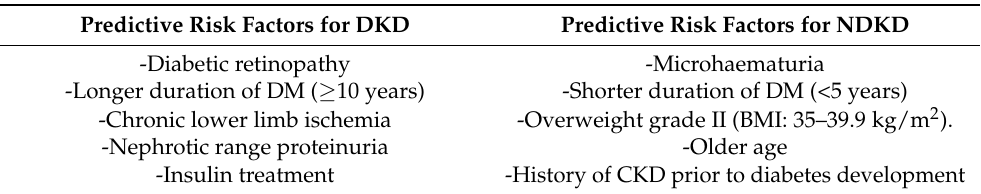
Table 1. Predictive risk factors for diabetic and non-diabetic kidney disease. Clinical findings that may help to identify diabetic and non-diabetic kidney disease in patients with diabetes and CKD. Predictive Risk Factors for DKD Predictive Risk Factors for NDKD -Diabetic retinopathy -Microhaematuria -Longer duration of DM ( ≥ 10 years) -Shorter duration of DM (<5 years) -Chronic lower limb ischemia -Overweight grade II (BMI: 35–39.9 kg/m 2 ). -Nephrotic range proteinuria -Older age -Insulin treatment -History of CKD prior to diabetes